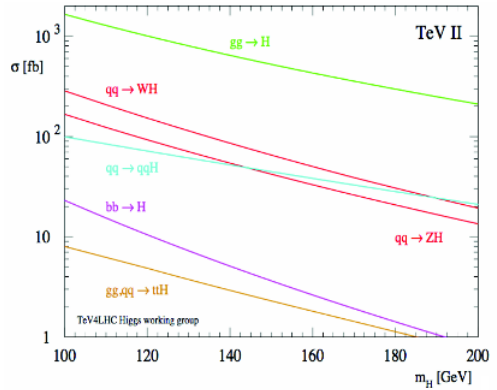
Fig. 1. Cross section of the di ff erent processes contributing to the SM Higgs boson production at the Tevatron p ¯ p collider ( 1 . 96 TeV) as a function of M H